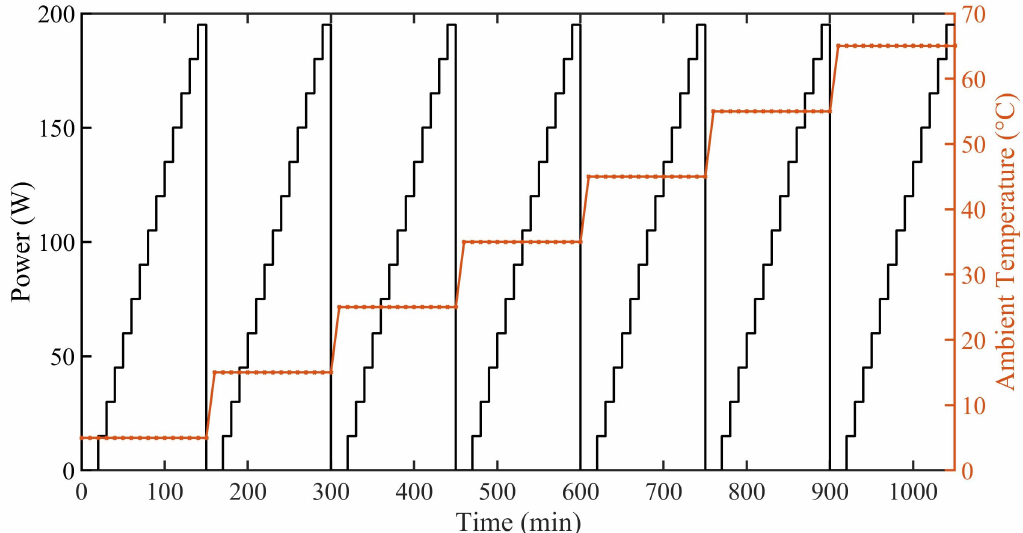
Figure 6. The power (W) and ambient temperature ( ◦ C) profile used as the input for the experimental validation of the electro-thermal DC–DC converter